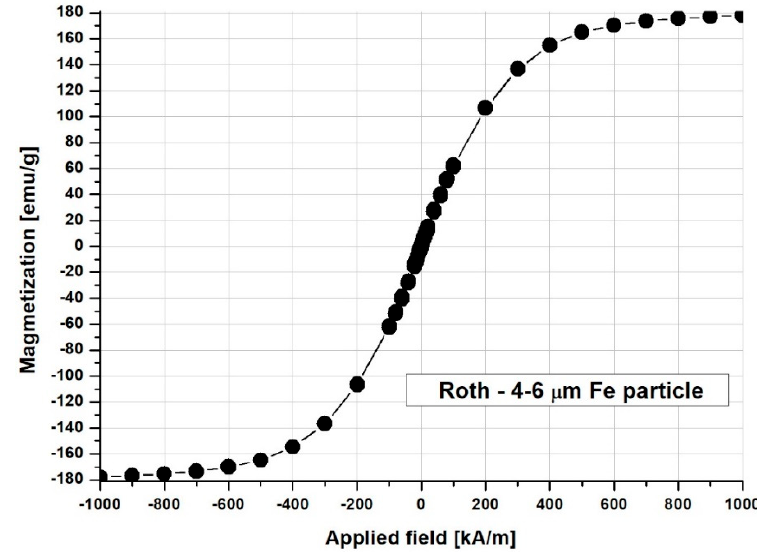
Figure 7. Microscopic image of the 4–6 µ m Fe powder’s morphology. The image shows particle size distribution variation from the indicated mean size and the presence of the particle cluster.